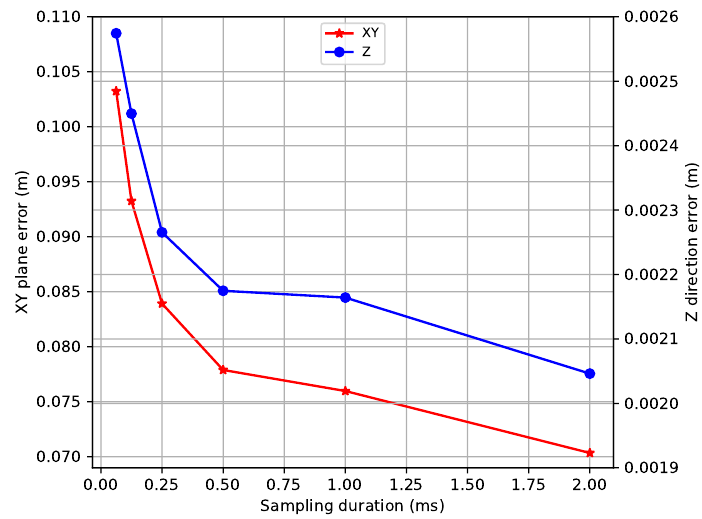
Figure 5. Localization error with respect to signal sampling duration.